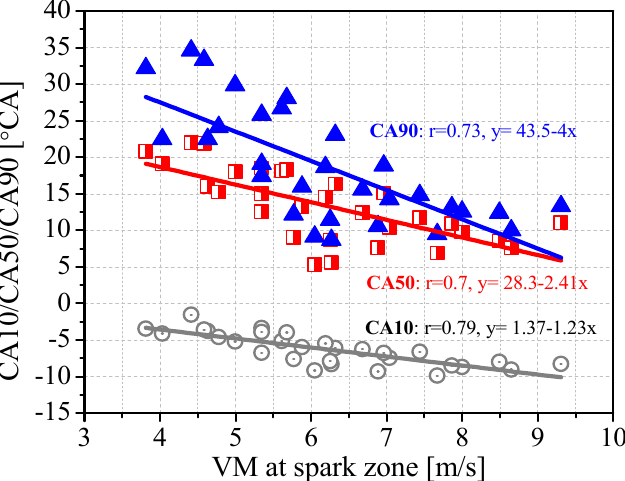
Figure 9. The correlations between the VM in spark zone at − 50 °CA and CA10, CA50 and CA90.